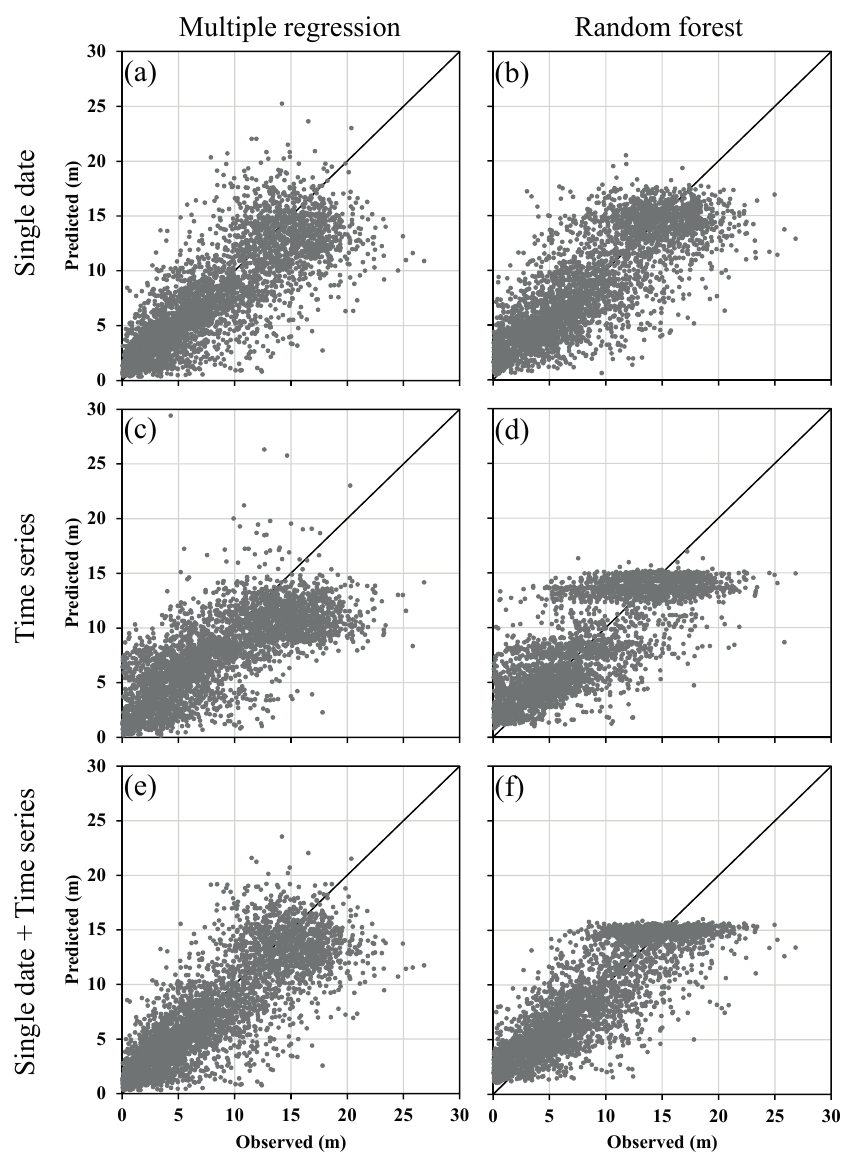
Figure 6. Validation result observed vs. predicted for MCH estimation using single date ( a , b ), time series ( c , d ) and combining both single date, and time series ( e , f ) with multiple regression (a,c,e) and random forest (b,d,f). The solid line shows the 1:1